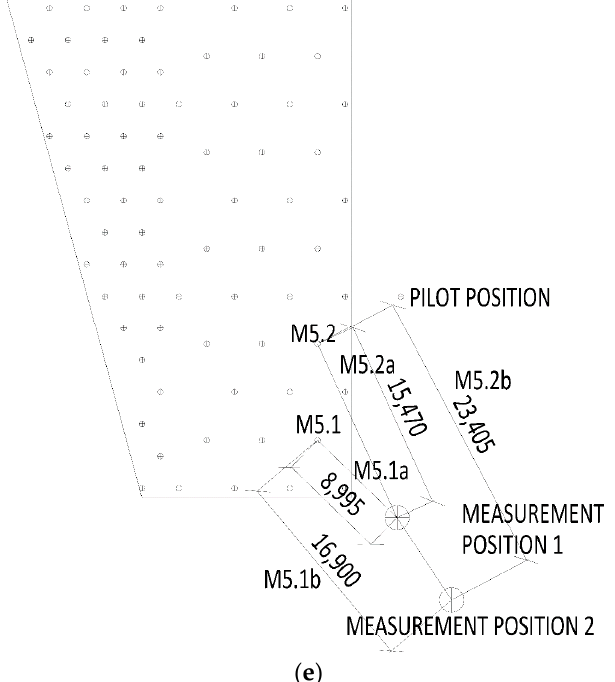
Figure A1. ( a – e ) Measuring situations 1–5 with distances between gravel piles and measuring stations marked.